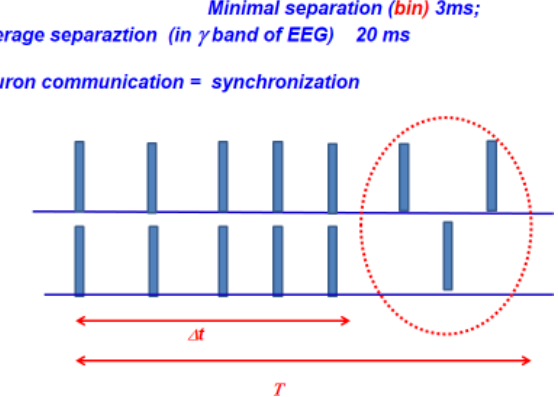
Figure 6. Direct coupling of two neurons by synchronized spike trains; synchronization missed after Dt for an extra-spike in the upper train.